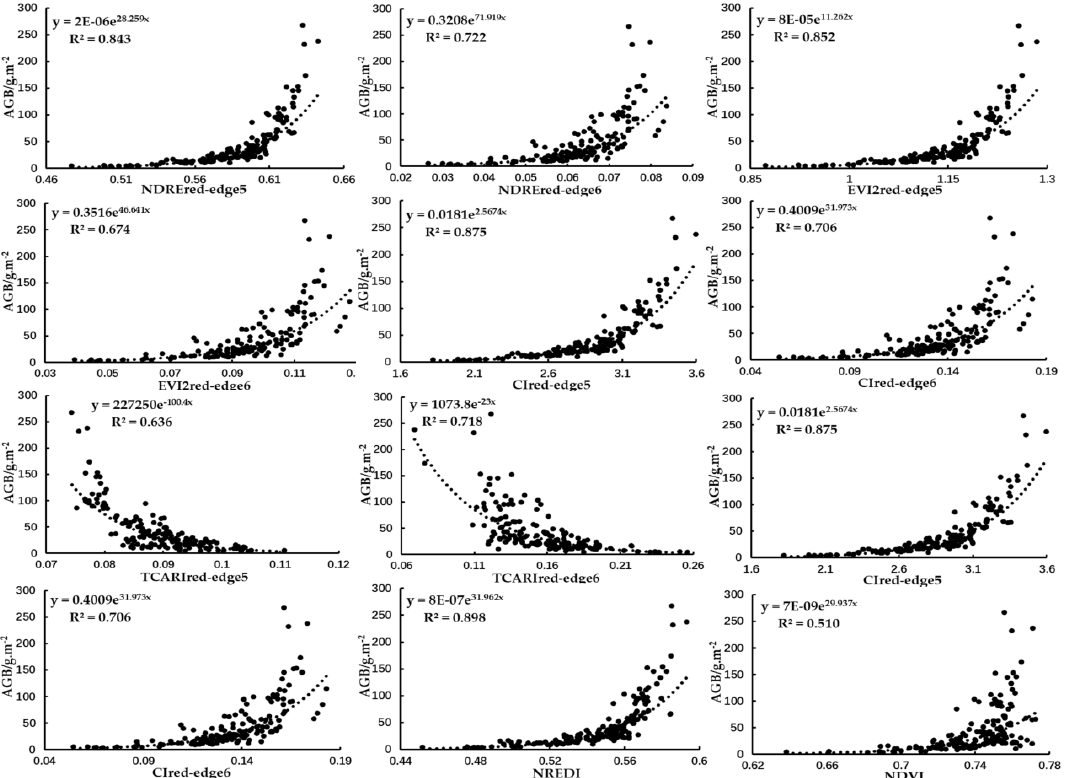
Remote Sens. 2021 , 13 , x FOR PEER REVIEW 19 of 26 Figure 13. The fitting results of red-edge vegetation index and simulated AGB based on GF-6 images at the pre-heading stage.